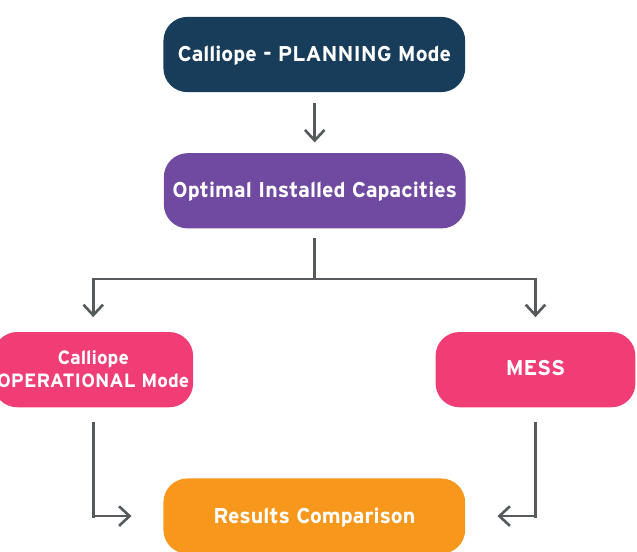
Figure 3. Schematic of the steps performed in the comparison between MESS and